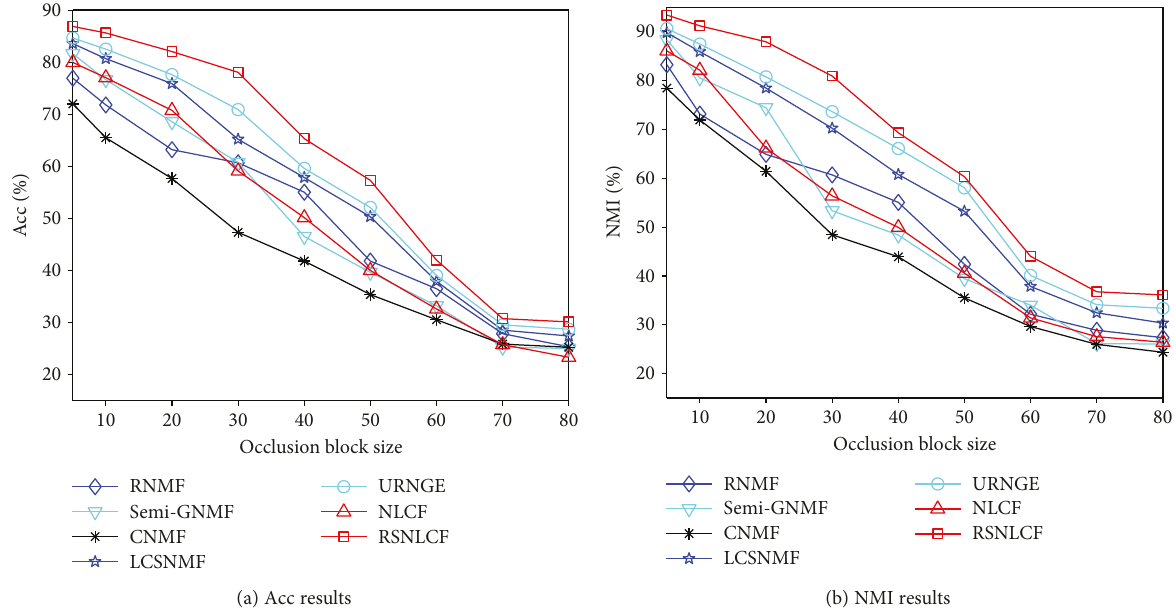
Figure 5: Clustering Acc and NMI curves of the compared methods under di ff erent occlusion levels with each image in the ORL dataset.